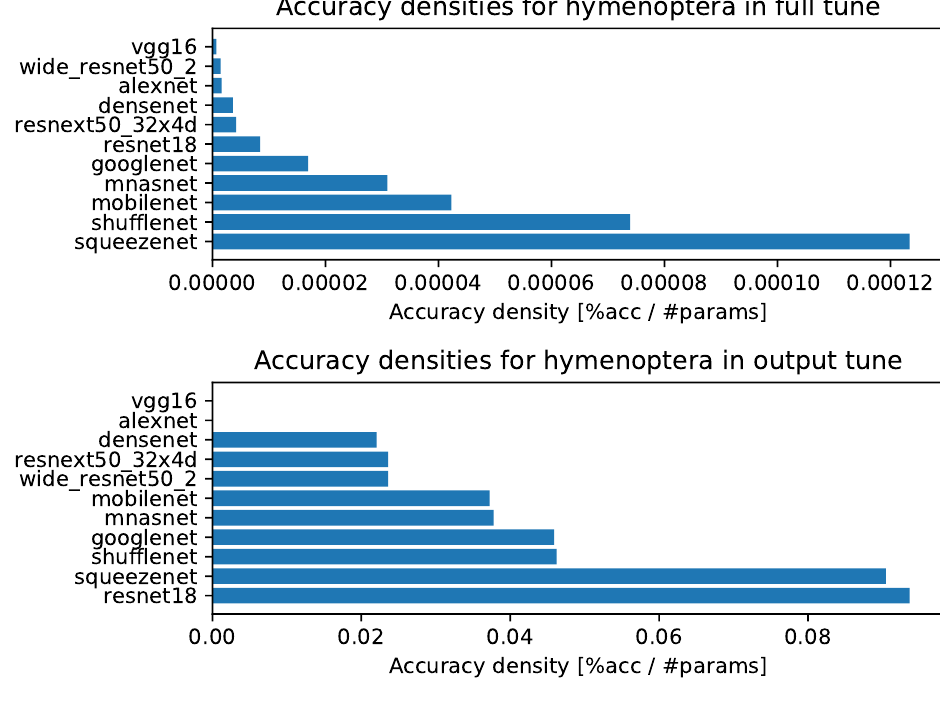
Figure A7. Accuracy densities for ten-episodes learning on Hymenoptera.